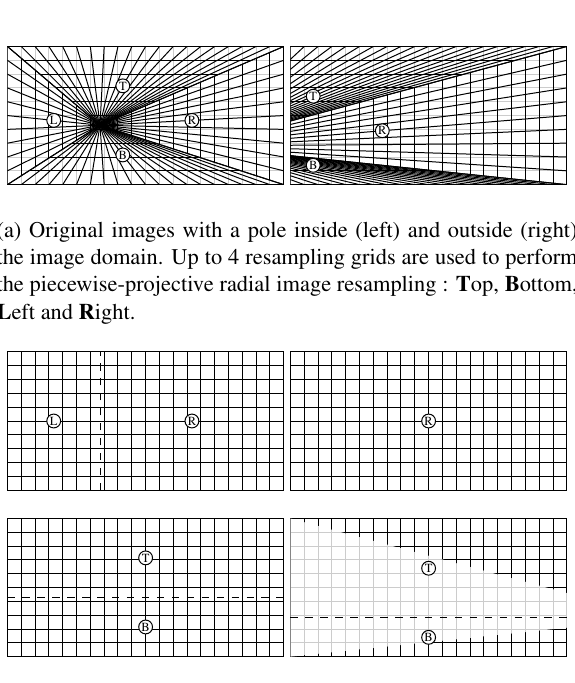
(b) Resampled image pairs Top/Bottom and Left/Right (left). The pole being placed on the left of the image domain, the L eft re- sampling grid is not used and the R ight resampling grid occupies the full image grid. Furthermore, less than half of the T op and B ottom pixels are sampled from the image domain, resulting in some memory over-allocation (right). Figure 3: Resampling Geometry of the Radial Images. Pixel cen- ters correspond to grid line